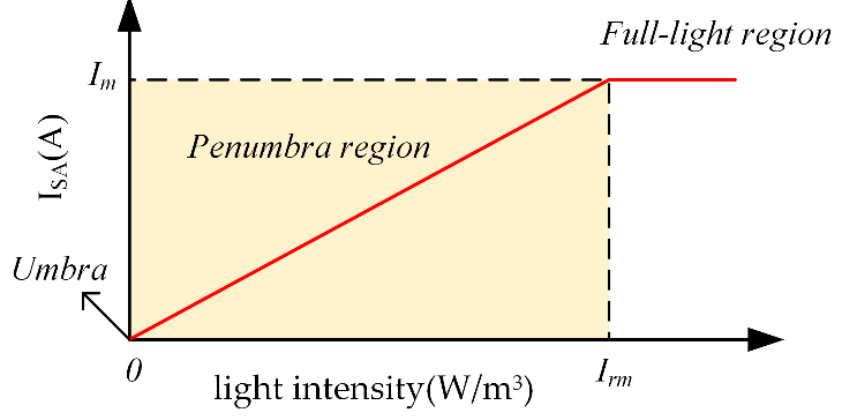
Figure 15. The relationship of I SA and light intensity during satellite exiting the earth eclipse.